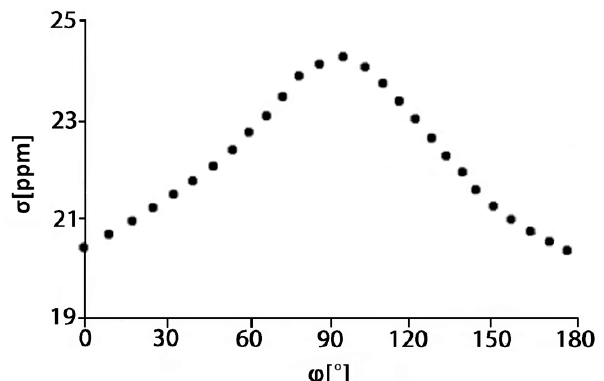
Figure 13. R–X ═ O H dihedral angle ( ϕ ) dependence of the nuclear shielding of the OH hydrogen of phenol. The hydrogen bond acceptor is acetone. Adapted with permission ••• from [44]. Copyright 2007, by John Wiley & Sons,